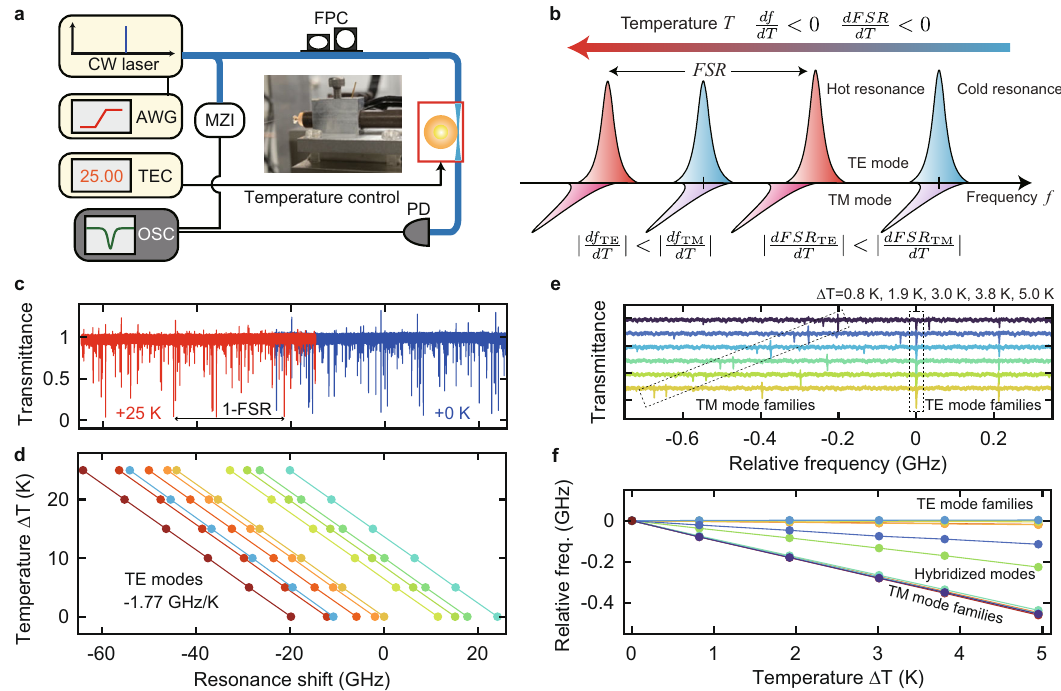
Fig. 1 Resonant frequency tuning ef fi ciency for orthogonally polarized modes in a crystalline MgF 2 microresonator. a Schematic experimental setup. Transmission spectra are recorded using a photodetector (PD) and an oscilloscope (OSC). The polarization of a continuous-wave (CW) laser is controlled by using a fi ber polarization controller (FPC). The frequency axis of the transmission spectrum is calibrated with the reference signal of a Mach-Zehnder interferometer (MZI). AWG arbitrary waveform generator, TEC thermoelectric cooler. b Orthogonally polarized modes exhibit a different tuning ef fi ciency with a temperature increase. Mode families belonging to the transverse-magnetic (TM) modes show greater ef fi ciency than transverse-electric (TE) modes due to the difference in the thermo-optic coef fi cient. c Transmission spectra at Δ T = 0 K (blue) and Δ T = 25 K (red). d Extracted resonance shifts for ten different modes in TE-polarization, which yields an average ef fi ciency of − 1.77 GHz/K. e The relative frequency shifts of TM mode families to the TE mode when the temperature is increasing by 5.0 K. f Extracted relative resonance shifts to one of the TE